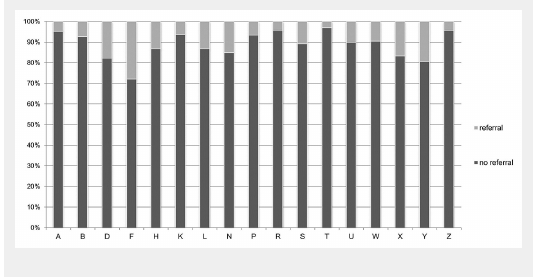
Referral rates according to ICPC-2 chapters. Percentage of reasons for encounter (RFE) according to ICPC-2 chapters which led to a referral (light) or were handled in primary care (dark). (A General and unspecified; B Blood, blood forming organs, lymphatic, spleen; D Digestive; F Eye; H Ear; K Circulatory; L Musculoskeletal; N Neurological; P Psychological; R Respiratory; S Skin; T Endocrine, metabolic and nutritional; U Urology; W Pregnancy, childbirth, family planning; X Female genital system and